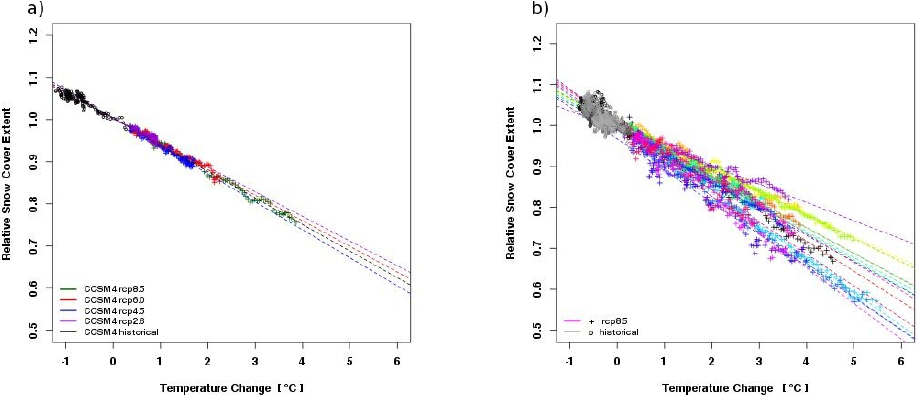
Figure 9: NH ice-free land spring (March-April) SCE (relative to 1986-2005) as a function of global mean annual mean surface air temperature (relative to 1986-2005), for the historical runs and the scenario runs